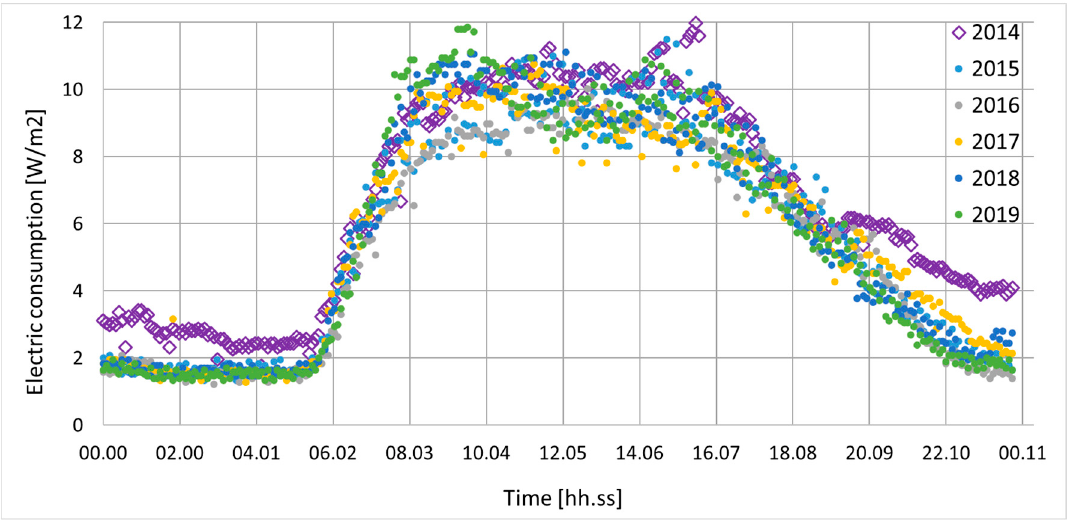
Figure 3. Daily consumption, February, Wednesdays from 2014 to 2019.